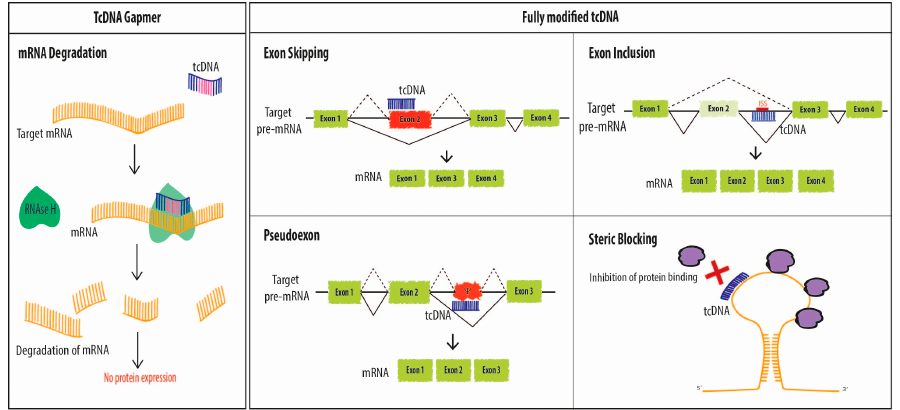
Figure 2. TcDNA-ASOs mechanisms of action. TcDNA, as other ASOs, may exert different effects